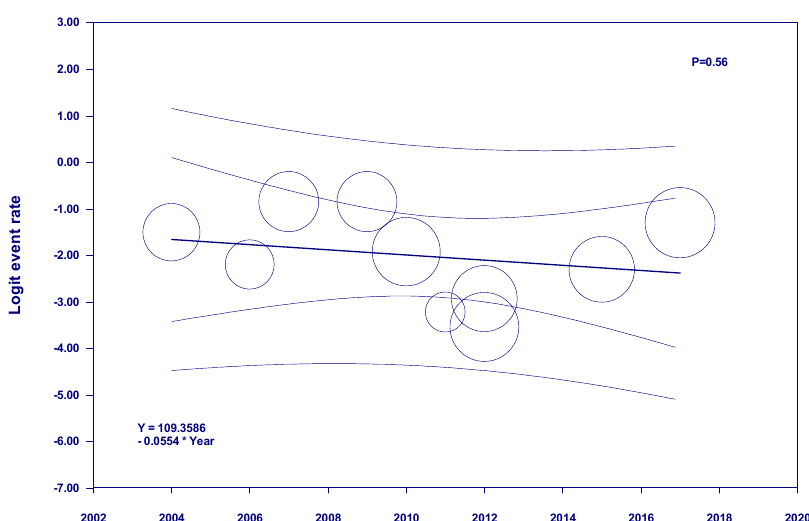
Figure 7. Meta-regression analyses, excluding the study of recurrent RCC among KTx recipients with a previous history of RCC prior to KTX, showed no significant correlations between the year of study and mortality of patients with RCC ( p = 0.56). The solid line represents the weighted regression line based on variance-weighted least-squares. The inner and outer lines show the 95% confidence interval and prediction interval around the regression line. The circles indicate log event rates in each study.